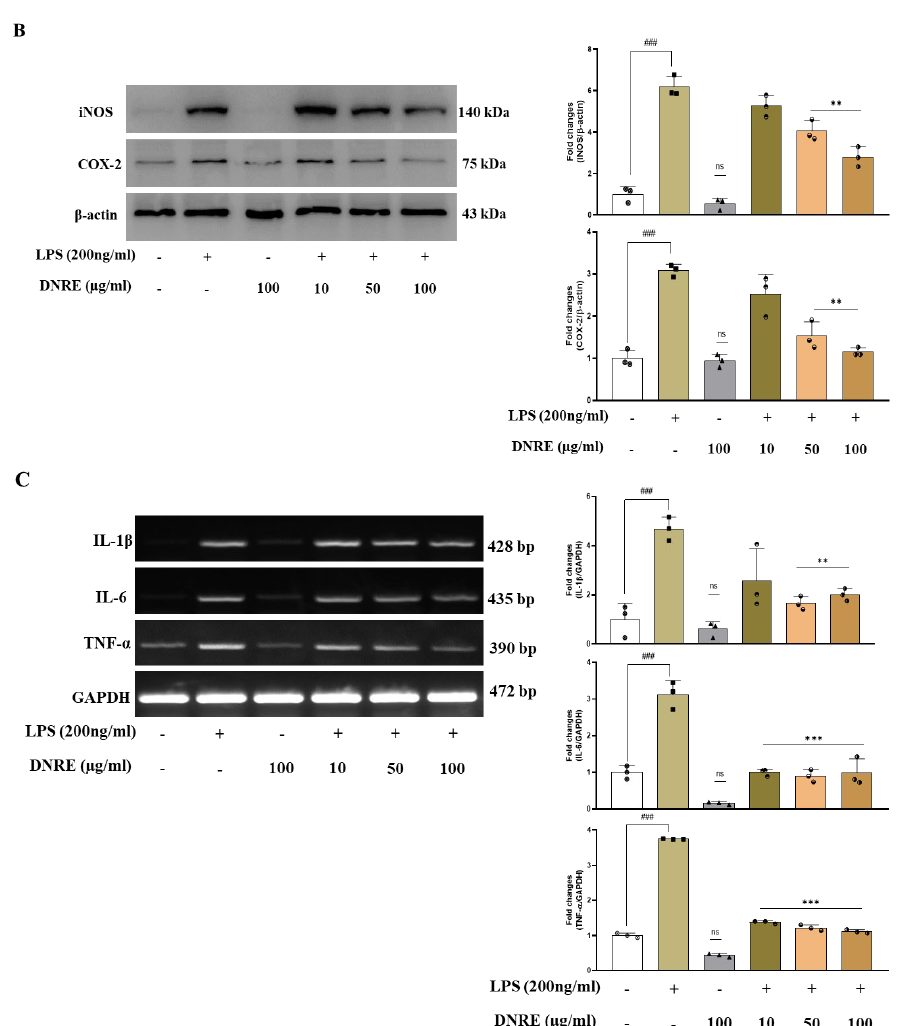
Figure 2. DNRE activities on inflammatory mediators. ( A ) mRNA and ( B ) protein expression of inflammatory enzymes in LPS (200 ng/mL)-treated BV-2 cells with or without different doses of DNRE. ( C ) mRNA expression of pro-inflammatory cytokines in LPS-treated BV-2 cells with or without DNRE. ns—not significant compared with non-treated; each shape (circles, triangles, squares, etc.) is representative of the number of repetitions of a particular group; ### p < 0.001 compared with non-treated; ** p < 0.01, *** p < 0.001 comparing LPS vs. LPS +